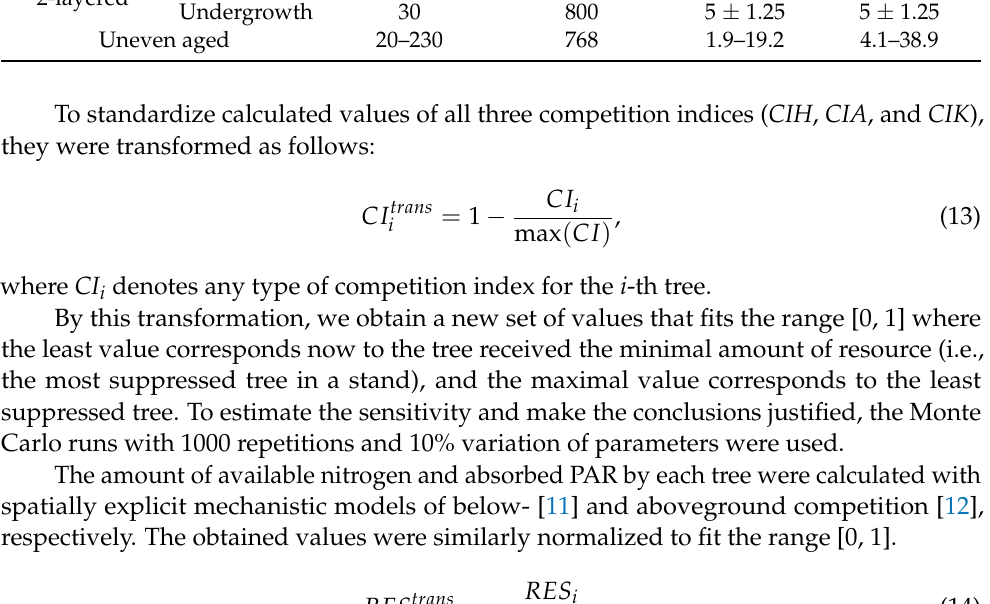
Table 2. Initial parameters ( ± standard deviation) of stands used for simulations. Stand Type Age, Years Density, ha − 1 Height, m DBH, cm Young 5 10,000 1.8 ± 0.45 1 ± 0.25 Pole 30 1600 5 ± 1.25 5 ± 1.25 Mature 70 448 22 ± 3.3 25 ± 3.75 Canopy 70 224 22 ± 3.3 25 ± 3.75 2-layered Undergrowth 30 800 5 ± 1.25 5 ± 1.25 Uneven aged 20–230 768